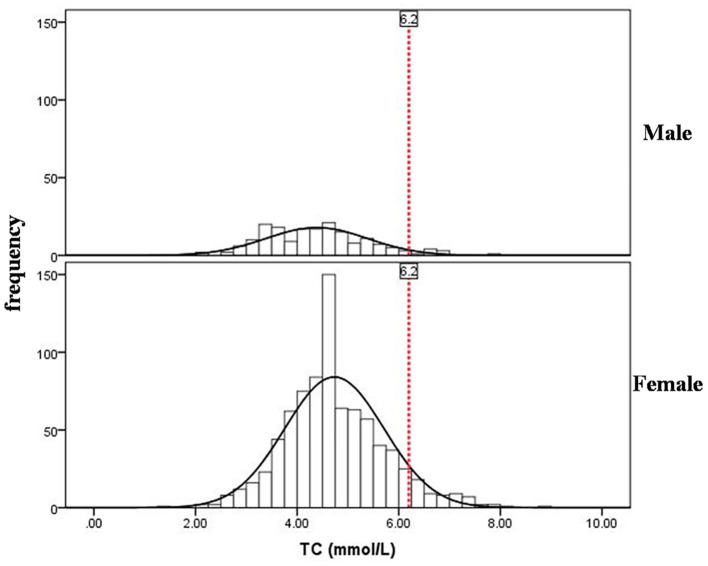
Distribution of serum total cholesterol levels in male and female centenarians. The red dotted lines represent normal reference values.